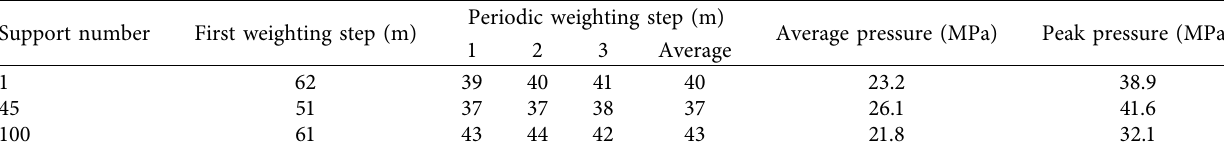
Figure 18: Monitoring diagram of typical hydraulic support. (a) 1# support (near the no roof cutting side). (b) 45# support (near the middle of the working face). (c) 100# support (near the roof cutting side). Table 3: Hydraulic support resistance statistic.